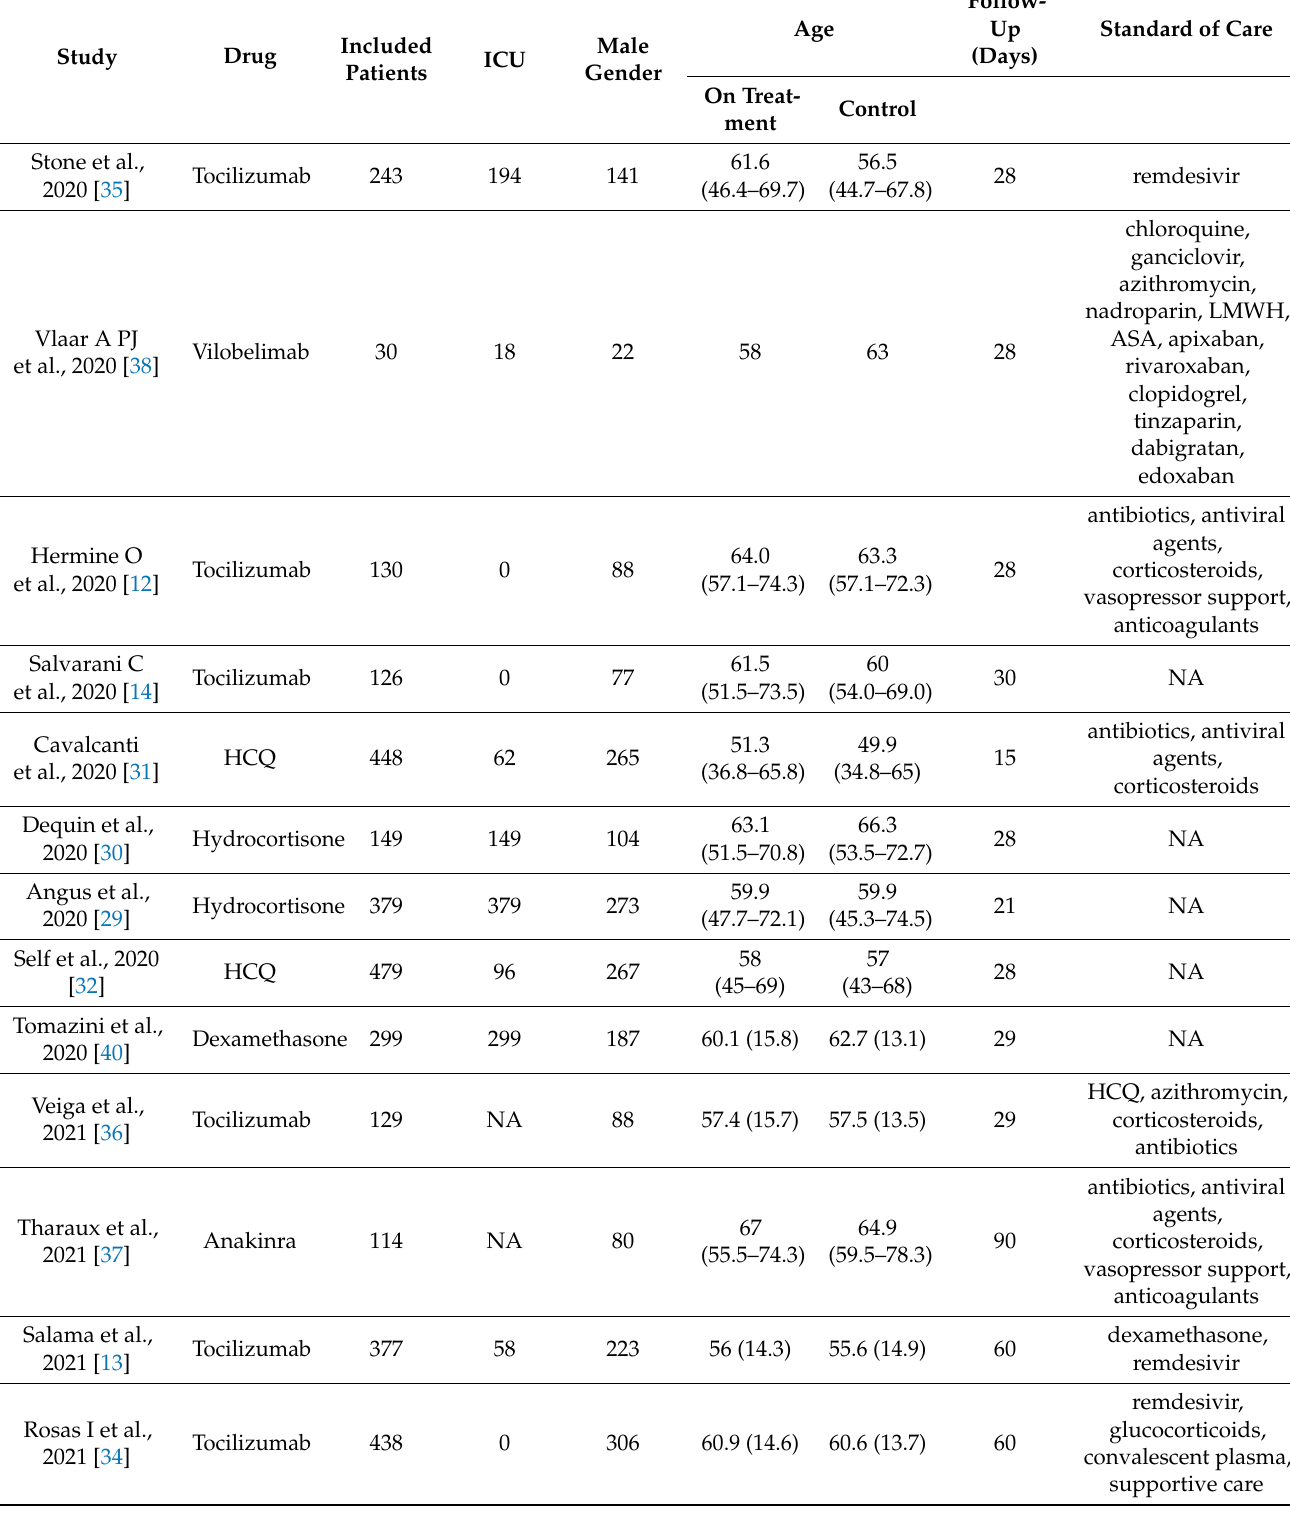
Table 1. Baseline characteristics of included